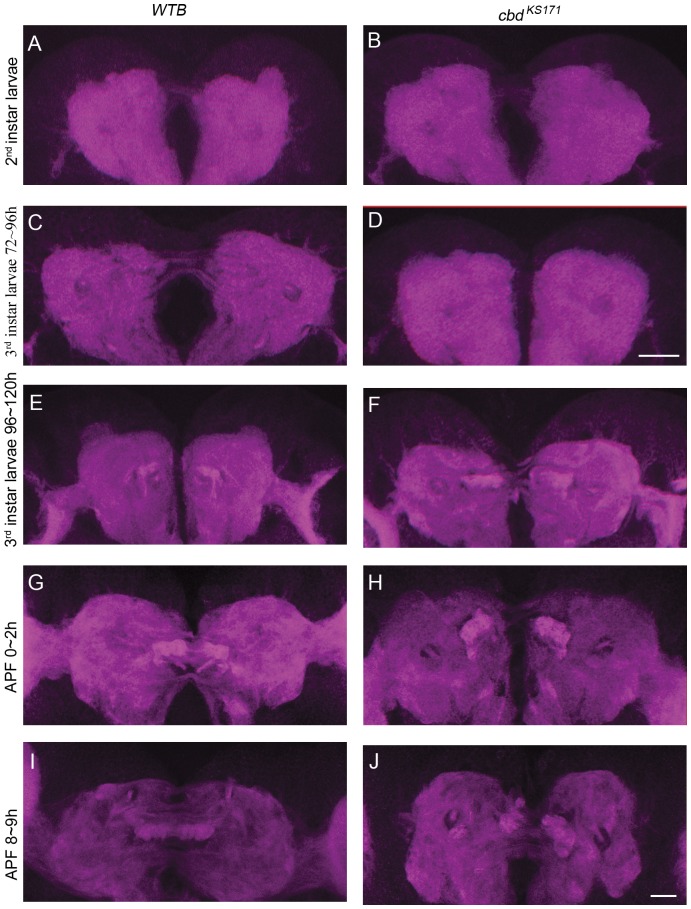
The development of the FB in both WTB and cbd KS171 from 2nd instar larva to pupa.(A–D) DN-cadherin signal in the commissure in 2nd instar larval brain of WTB (A) or cbd KS171 mutant (B), and in early 3rd instar larval brain of WTB (C) or cbd KS171 mutant (D). Scale bar in (D) equals 25 µm and applies to (A–D). (E–J) FB precursors strongly labeled by DN-cadherin in the commissure in a late 3rd instar larval brain from WTB (E) or a cbd KS171 mutant (F), and in a 0–2 h APF pupal brain from WTB (G) or a cbd KS171 mutant (H), and in an 8–9 h APF pupal brain from WTB (I) or a cbd KS171 mutant (J). Scale bar in (J) equals 25 µm and applies to (E–J).